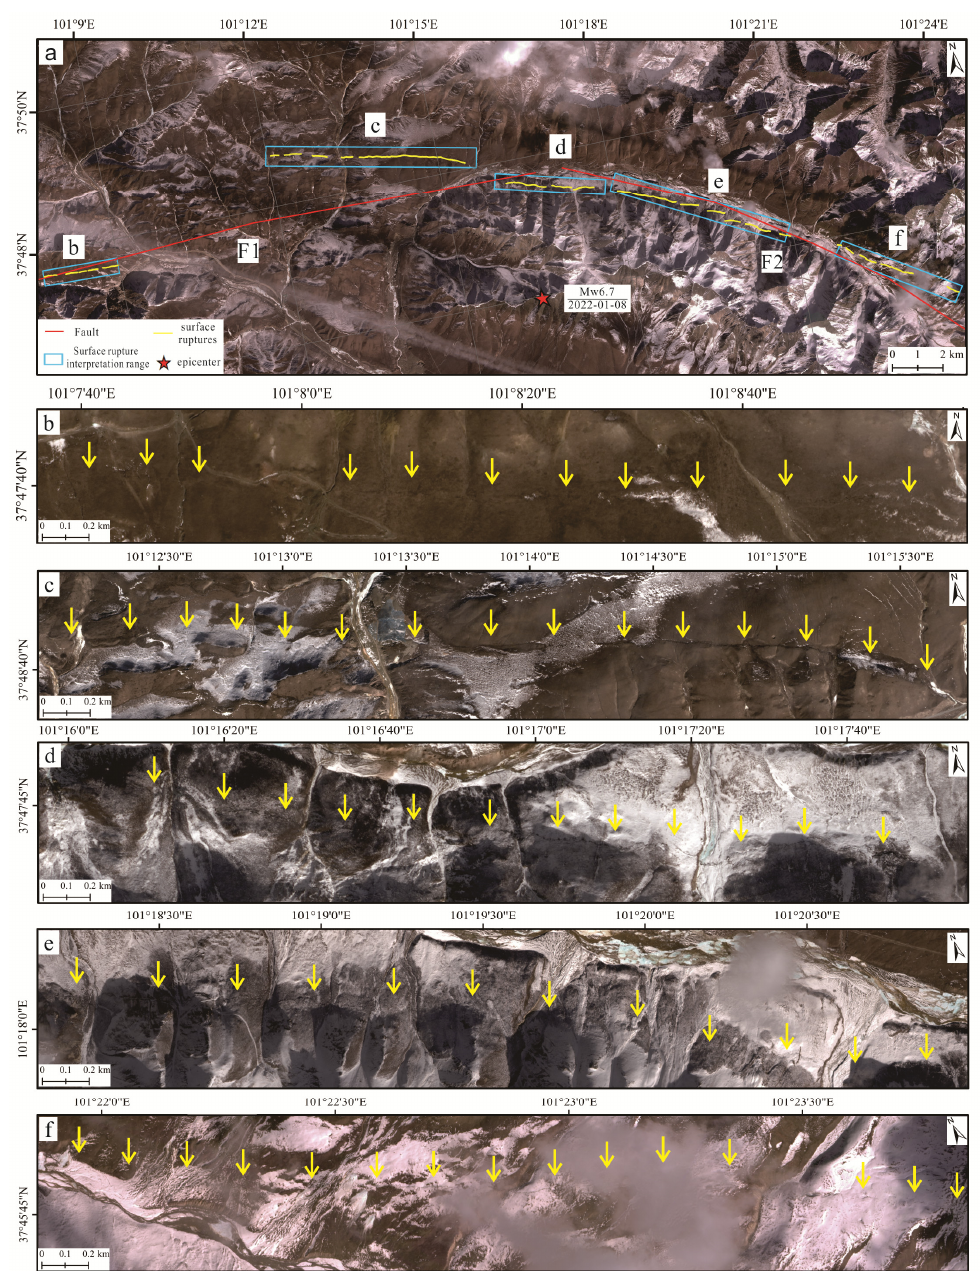
Figure 2. Surface rupture zone interpretation results of the 2022 Menyuan earthquake. F1 is the Tuolaishan fault. F2 is the Lenglongling fault.